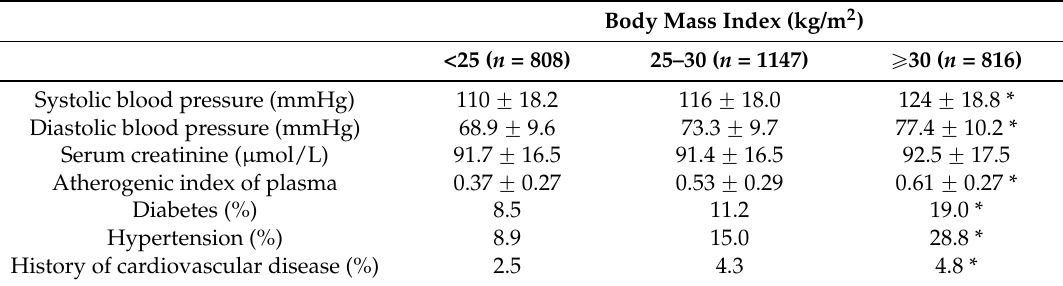
Table 4. Cardiovascular risk factors across categories of body mass